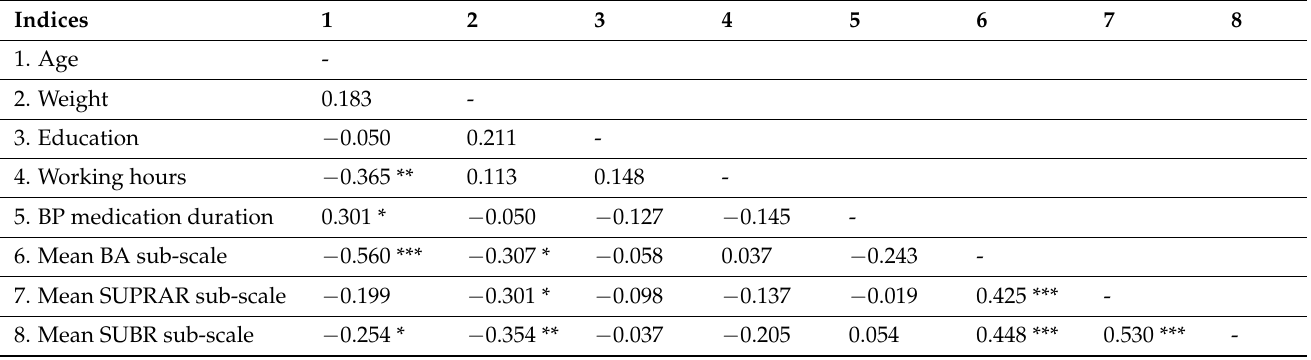
Table A2. Pearson correlations and significance of Demographic variables.